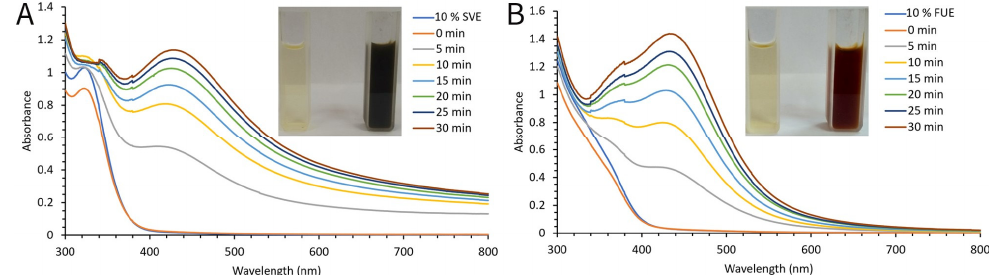
Figure 3. Time-dependent UV-Vis absorption spectra of SVAgNP ( A ) and FUAgNP ( B ) synthesis under optimal conditions.